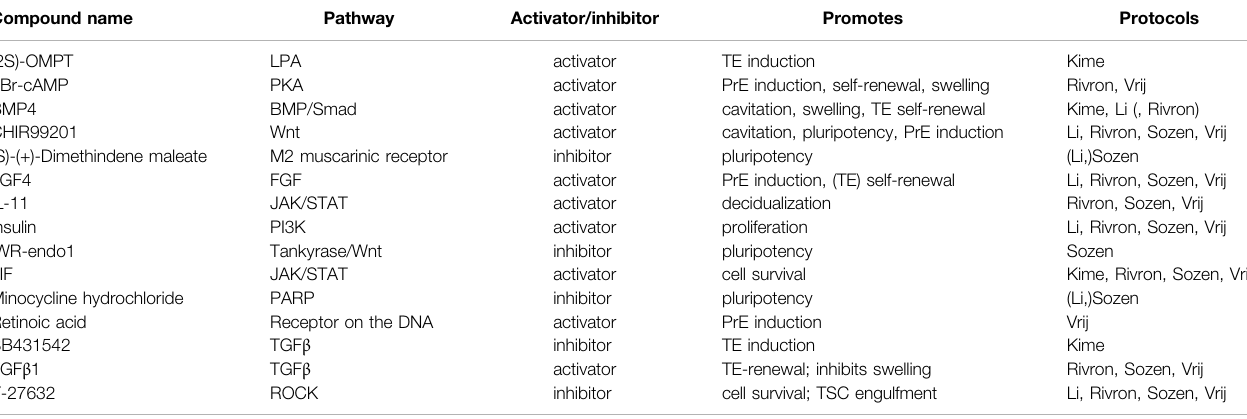
TABLE 3 | Small molecules applied in mouse blastoid protocols. When a protocol is listed in brackets, the molecule is used in a screening or cell culture maintenance medium, but not included in the standard blastoid generation protocol. Compound